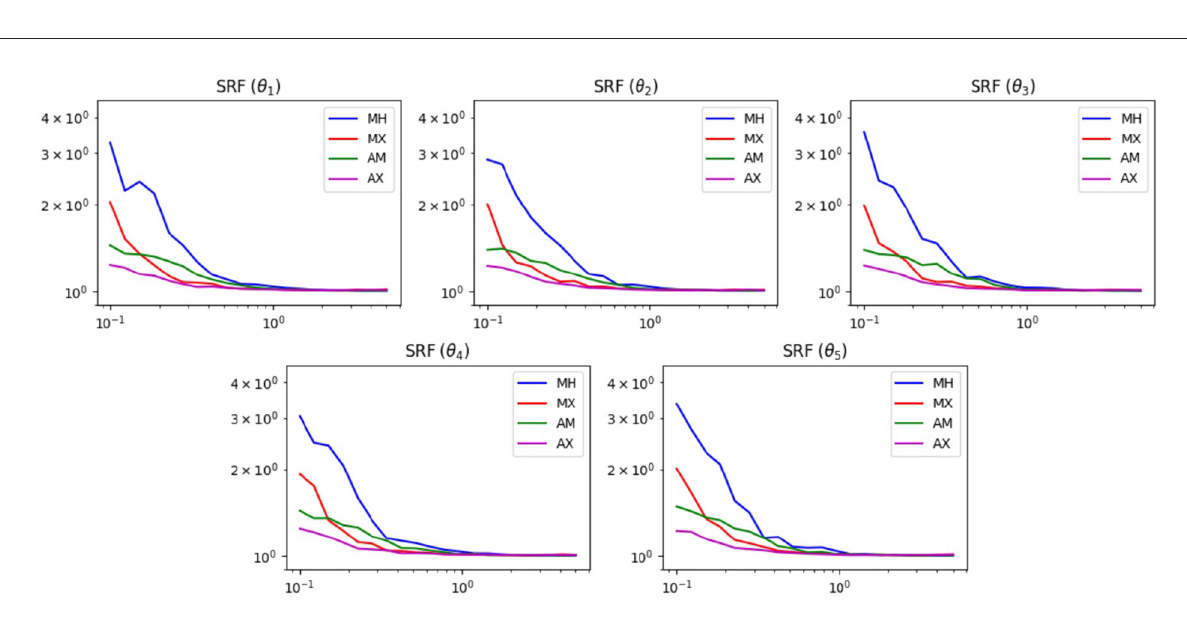
mixing probabilities used were ( p t , p f , p w ) = (3 / 5,1 / 3, 1 /